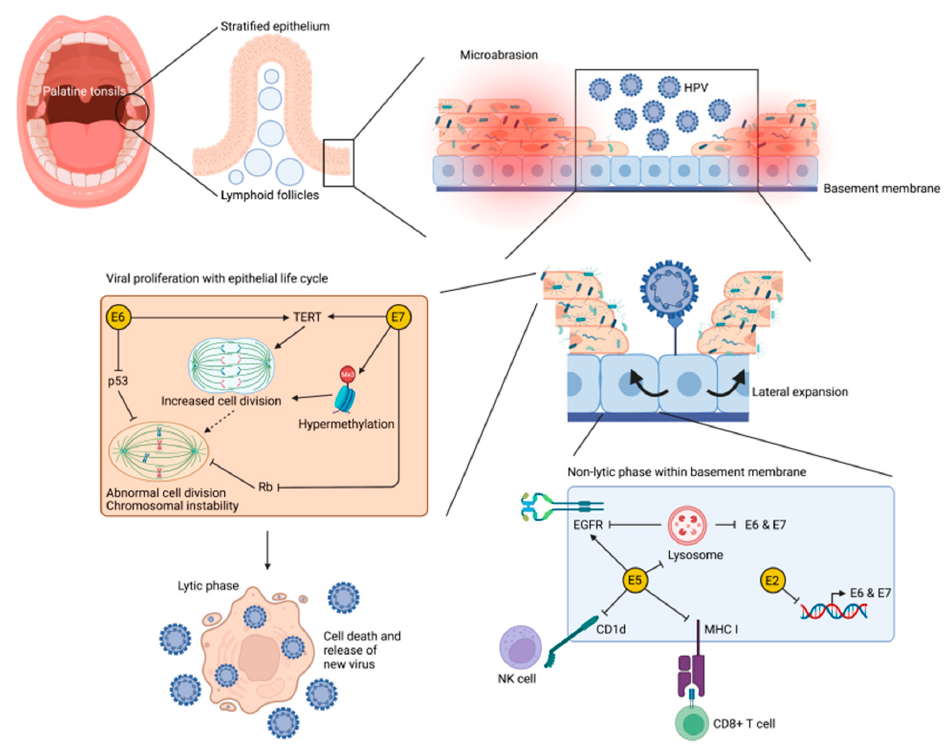
Figure 2. Interplay of HPV, the microbiome, and the oropharynx. Overview of the HPV lifecycle within a tonsillar tumor. Microabrasions in tonsillar epithelium lead to HPV infection of basilar and epithelial cells. Basilar cells undergo lateral expansion during the non-lytic phase of the viral cycle, primarily mediated by E5 [43]—which modulates EGFR signaling [44], downregulates CD1d [45], prevents MHCI trafficking [46], and regulates autophagy [47]. Epithelial cells undergo proliferation and transformation prior to the lytic phase of the virus’s life cycle, primarily mediated by E6 (which degrades p53) and E7 (which similarly degrades Rb) [48]. E6 and E7 also affect cell division via TERT and methylation [49,50]. Figure generated using